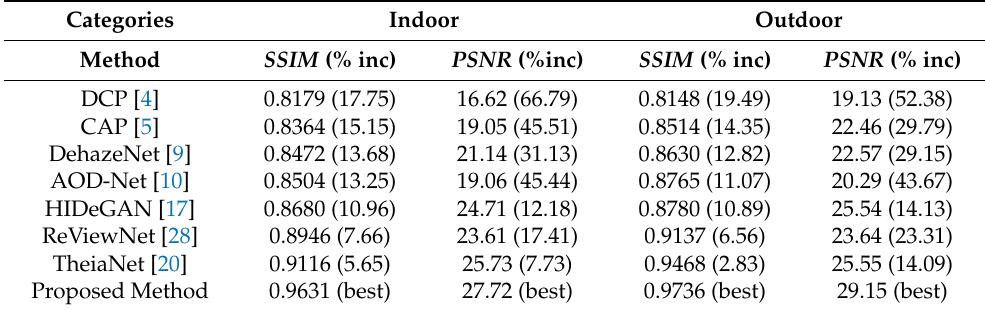
Table 6. Comparison of dehazing results on RESIDE SOTS